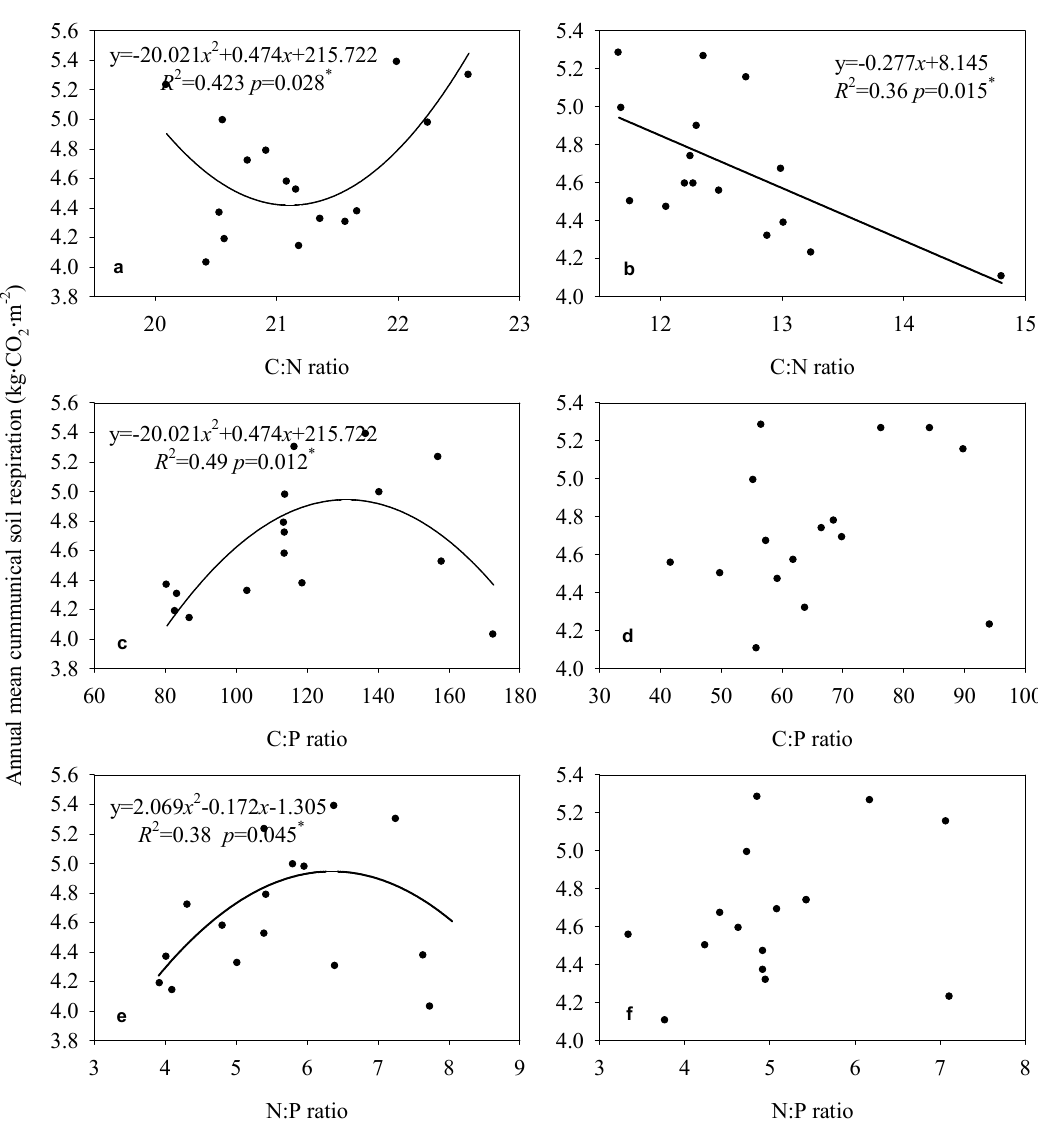
Figure 8. Relationships between the annual mean cumulative soil respiration rate and stoichiometry in soil (0–20 cm) on moso bamboo. The data means three plots in each stand and the total mean value of each stand ( n = 16). ( a , c , e ), is the relationships between annual mean cumulative respiration and soil C:N ratio, C:P ratio and N:P ratio in 0–10 cm; ( b , d , f ), is the relationships between annual mean cumulative respiration and soil C:N ratio, C:P ratio and N:P in 10−20 cm.